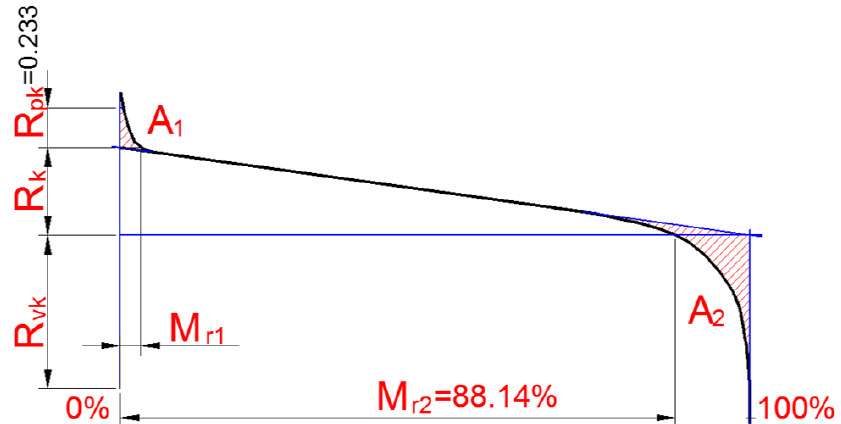
Figure 6. Abbott-Firestone diagram for the inner cylindrical surface of the specimen obtained after finish rolling: R pk — reduced peak height; R k — profile core depth; R vk — reduced valley depth; Mr 1 — percentage of the material separated by a line that separates the peaks from the profile core; Mr 2 — percentage of the material separated by a line that separates the valley from the profile midline.